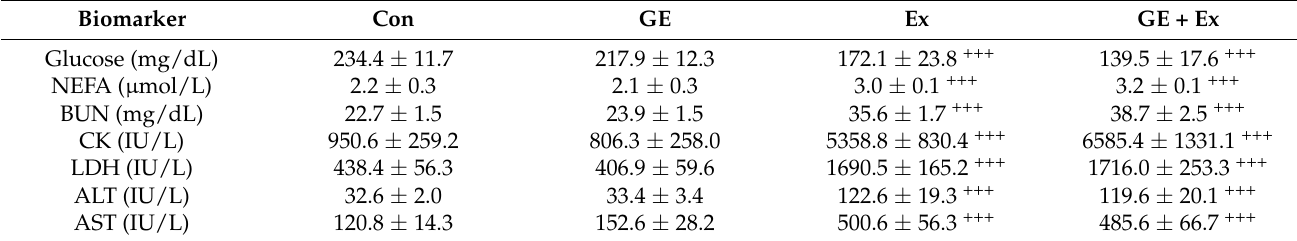
Table 2. The results of blood biomarkers